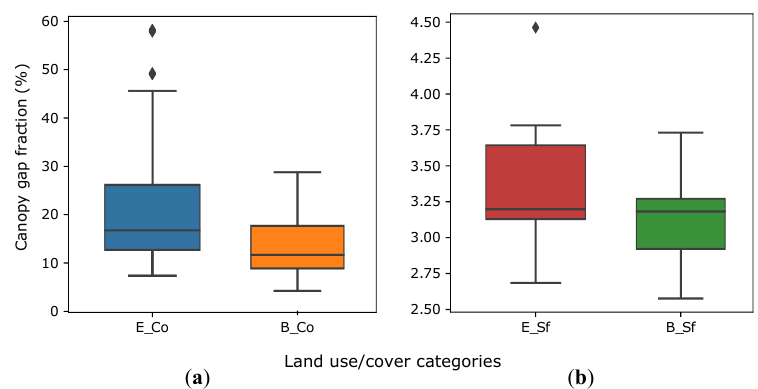
Figure 6. Boxplot of estimated gap fraction aggregated by land use categories in the 2 study sites: ( a ) Cocoa agroforests. ( b ) Transition forests. B-Co: Cocoa agroforests in Bokito, B-Sf: Secondary/Transition forests in Bokito, E-Co: Cocoa agroforests in Efoulan, and E-Sf: Secondary/Transition forests in